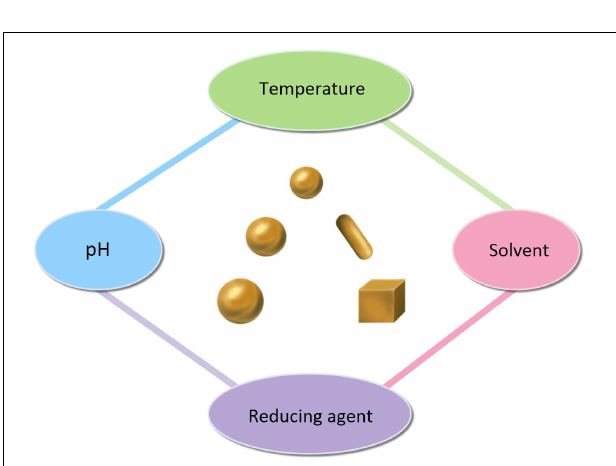
FIGURE 6 | The factors affecting the size and shape of AuNPs.